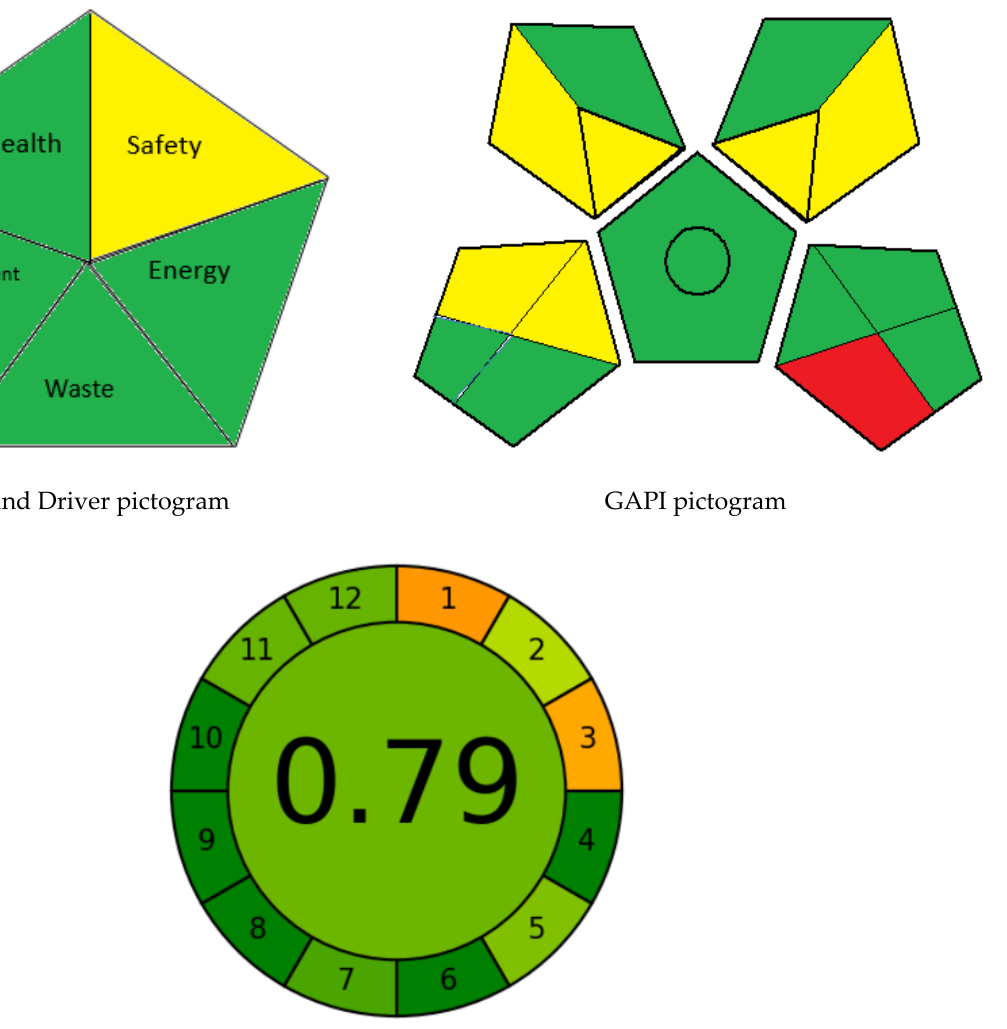
Figure 5. Assessment of the greenness profile of the developed methods using Raynie and Driver, GAPI and AGREE pictograms.